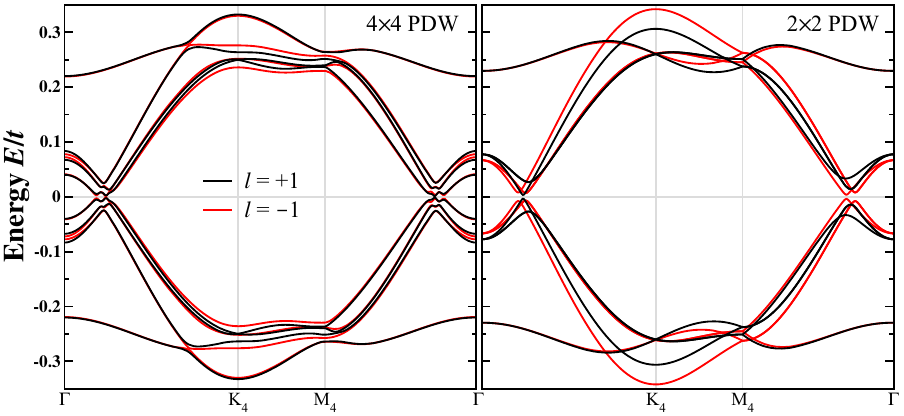
Fig. 8 | 4 a 0 ×4 a 0 and 2 a 0 ×2 a 0 PDW. Low-energyBdG quasiparticlebandsforthe 3 Q PDW ±1 states with Δ p =0.1 t along high-symmetry path in the 4×4 reduced BZ.